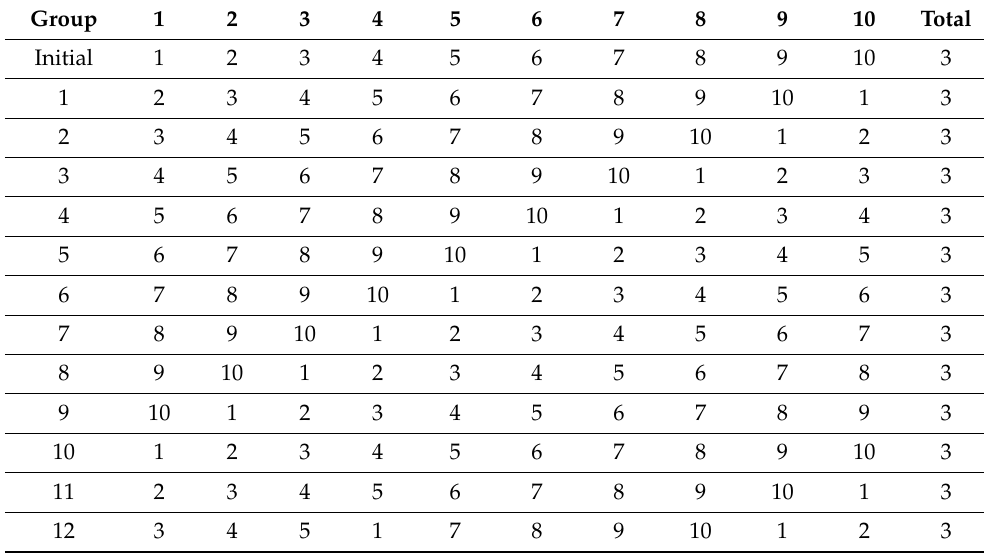
Table 1. The linear distribution of air-conditioning polymerization group status.